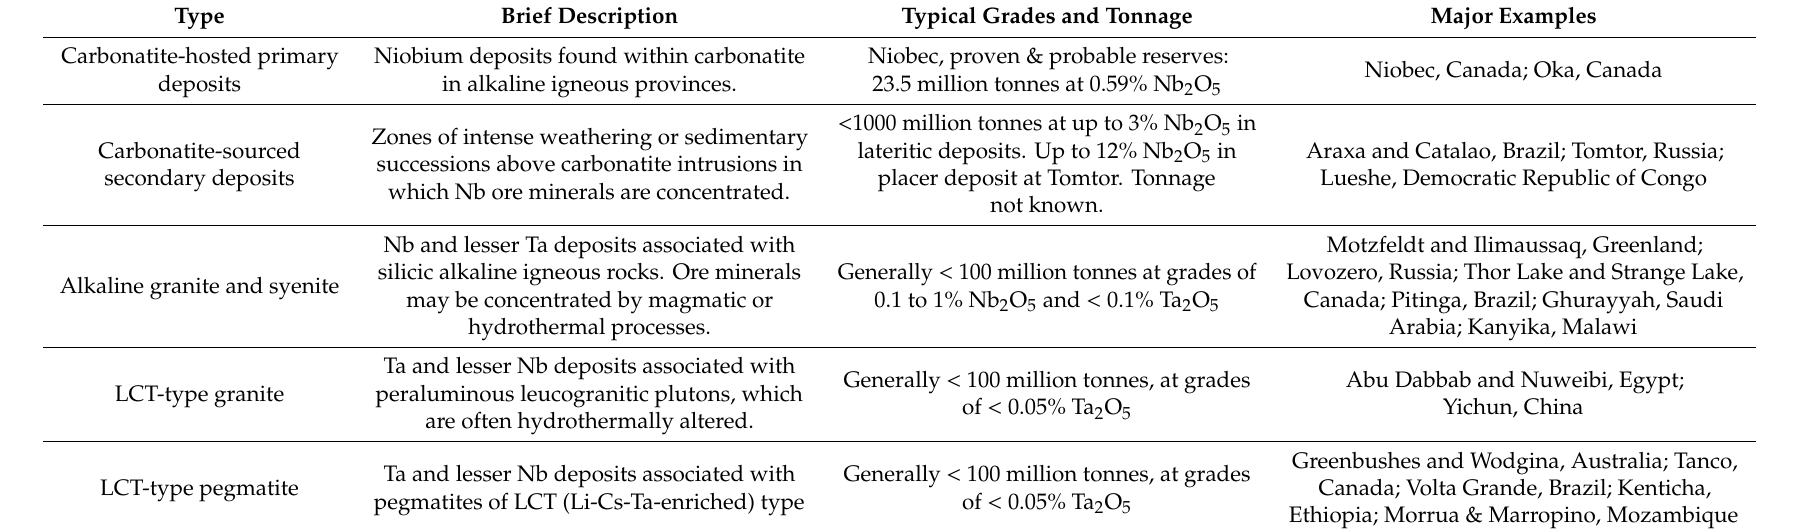
Table 1. Common types of Ta-Nb deposits with a brief description, grade, tonnage, and examples